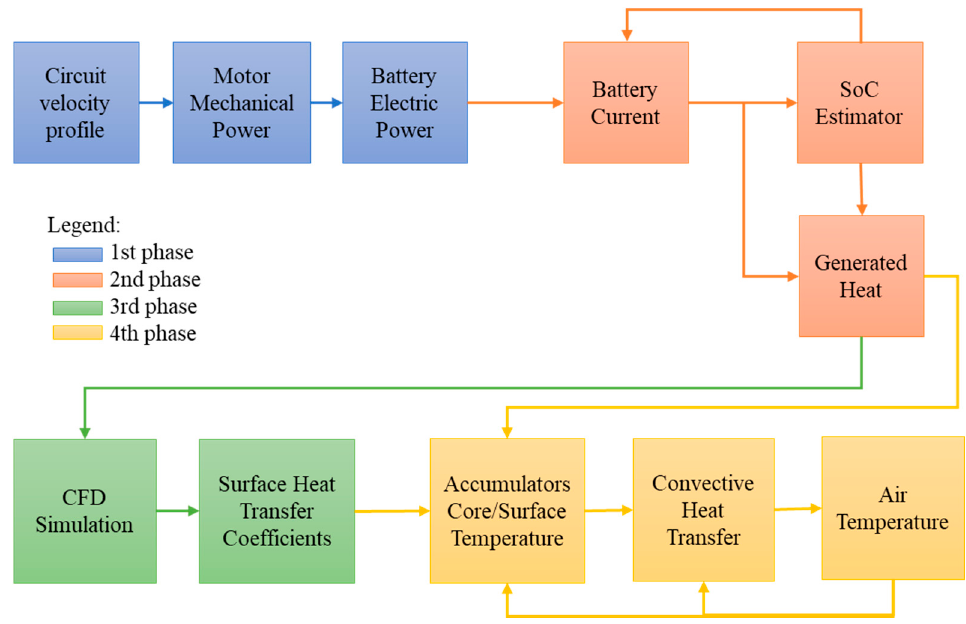
Figure 1. Research methodology